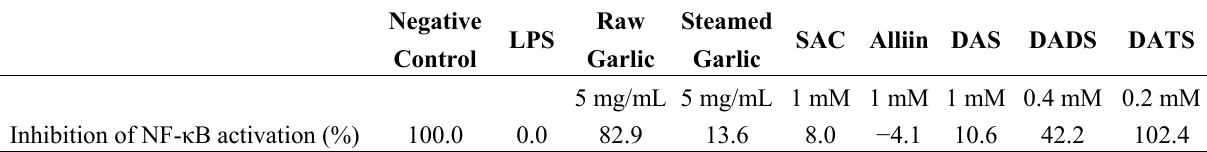
Table 3. Inhibitory rate of garlic extracts and selected OSCs on the NF-κB binding activity in LPS-activated RAW 264.7